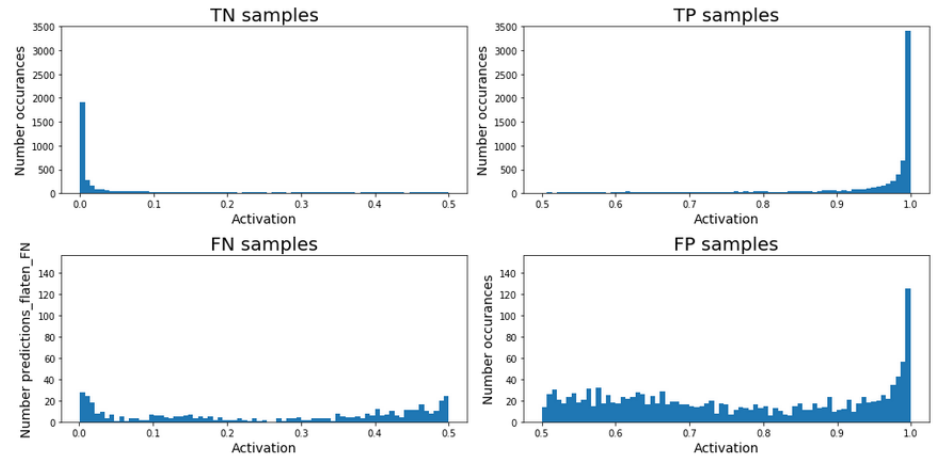
Figure 16. Confidence-level analysis of the RNN-based model for tv D6WH (MUAC region). ( top-left ) TN, ( top-right ) TP, ( bottom-left ) FP, and ( bottom-right ) FN cases.